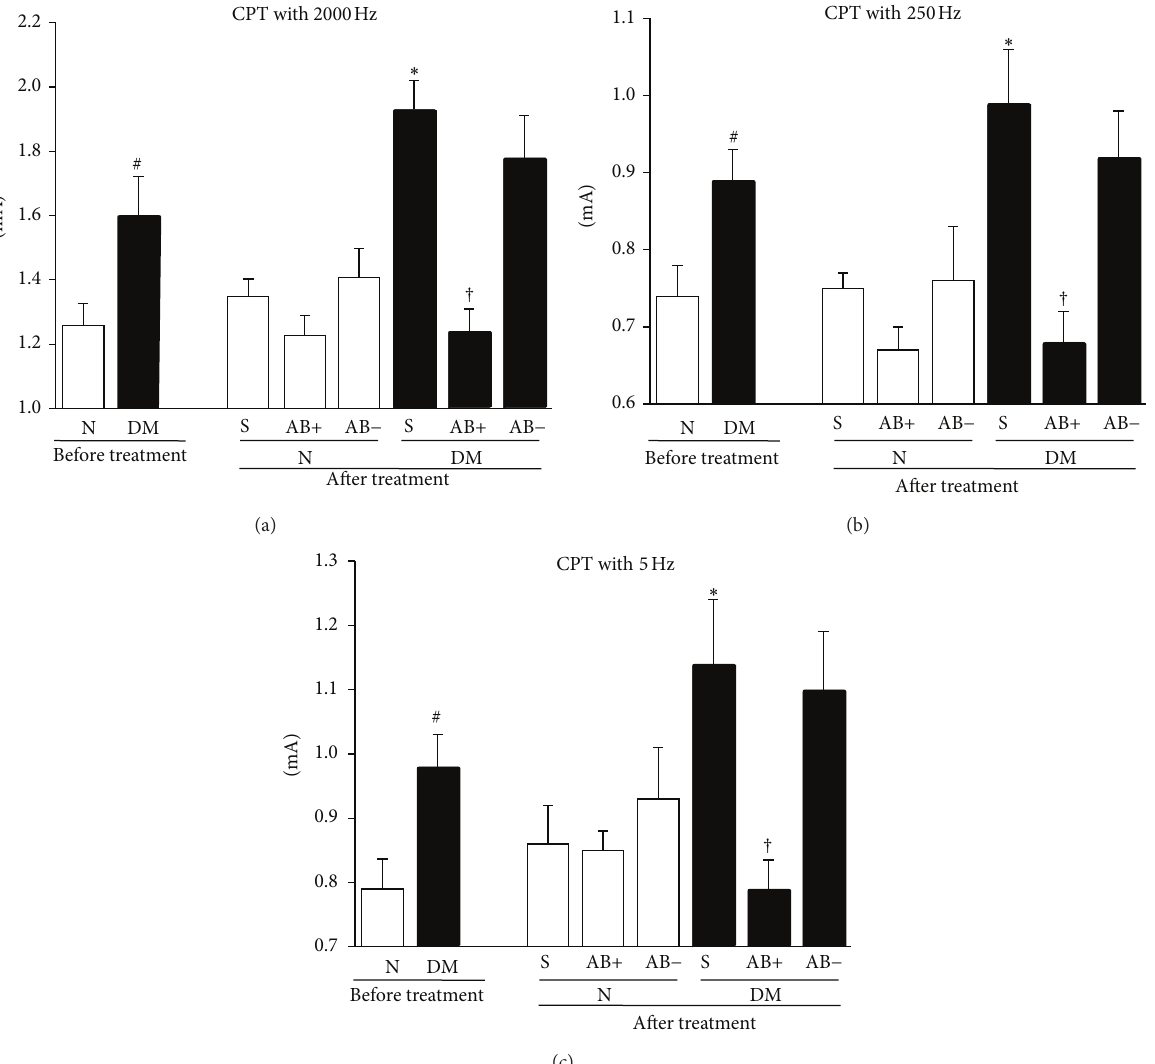
Figure 8: Impaired sensory perceptions in diabetic mice were ameliorated by angioblast-like cells induced from ES cells (ES-ABs) transplantation. Stimuli with frequencies of 5 Hz (a), 250 Hz (b), and 2000 Hz (c) evoked excitations of C-fiber, A 𝛿 -fiber, and A 𝛽 -fiber, respectively. Before cell transplantation, CPTs with all kinds of stimuli in diabetic mice had significantly increased compared with those in normal mice, representing hypoalgesia in diabetic mice. Four weeks after the transplantation of ES-ABs, these deficits in sensation were significantly improved in diabetic mice compared with saline-treated diabetic controls. The transplantation of ES-ABs into normal mice did not induce significant changes in CPTs. N: normal mice limbs, DM: diabetic mice limbs, S: saline-injected limbs, AB+: limbs transplanted ES-ABs, and AB − : contralateral limbs transplanted ES-ABs. Results are means ± SD. # 𝑃 < 0.05 versus pretreatment N, ∗ 𝑃 < 0.05 versus posttreatment S-treated N, and † 𝑃 < 0.05 versus posttreatment S-treated DM. 𝑛 = 8 –10 in each nondiabetic group and 𝑛 = 7 –9 in each diabetic